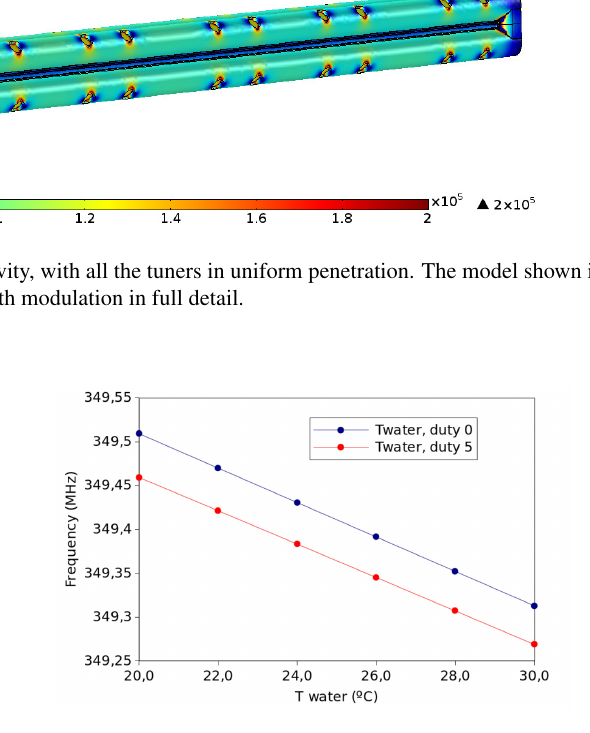
Figure 17. Change in cavity frequency with cooling water tem- perature, for two di ff erent RF power conditions. The results come from steady-state simulations.